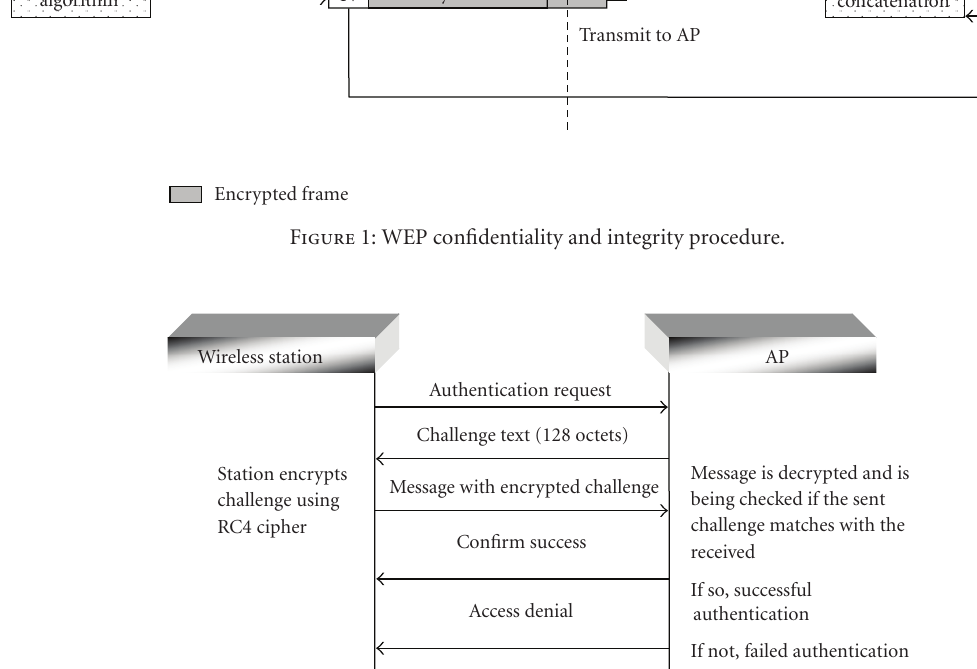
Figure 2: 4-way message